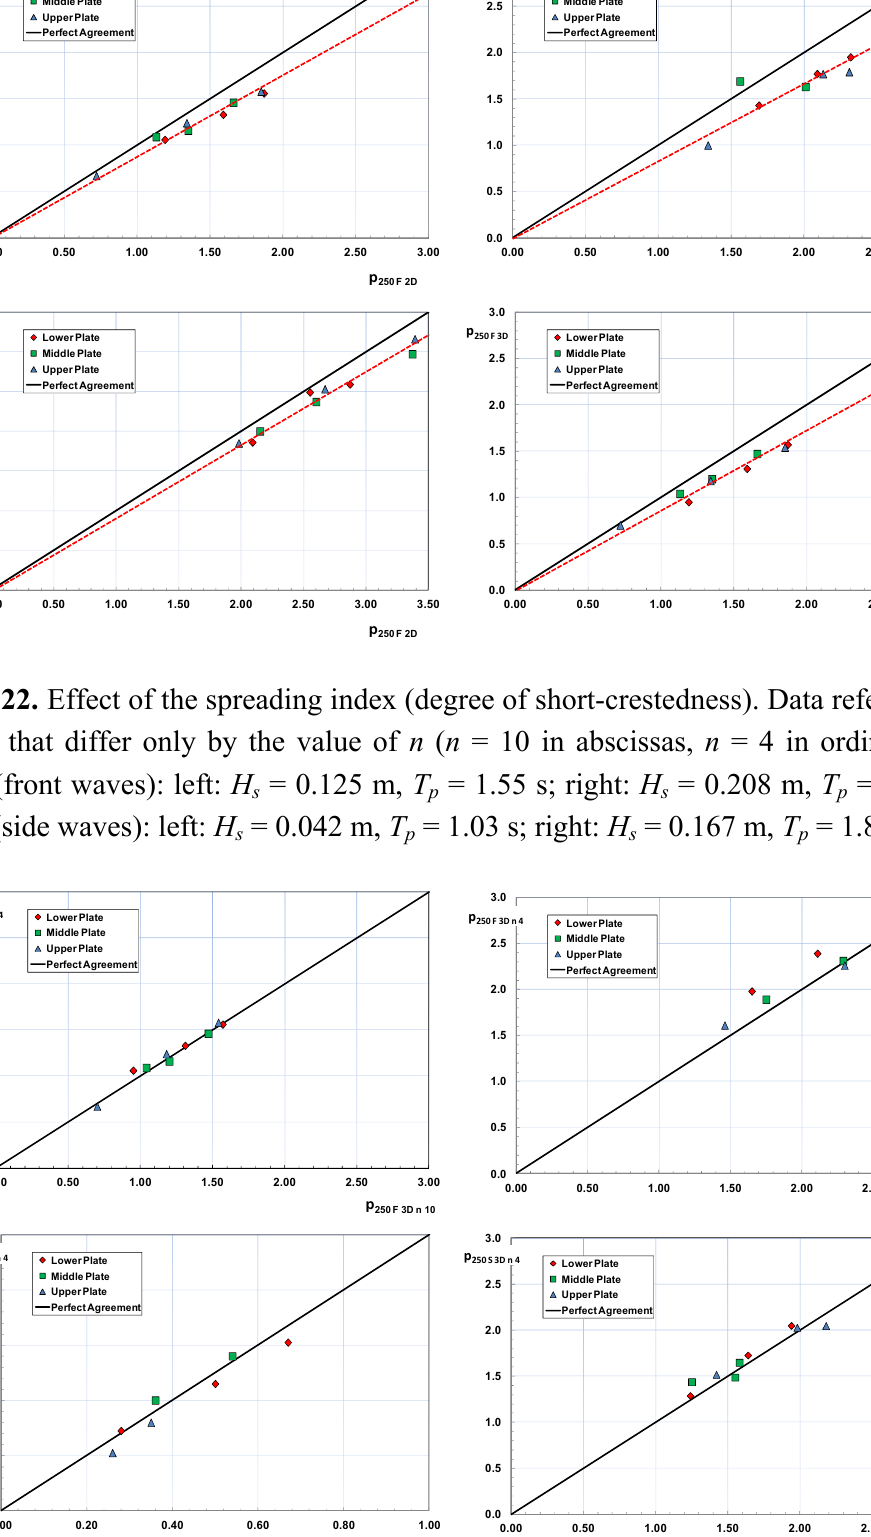
Figure 21. Long crested vs. short crested waves ( n = 4, front waves). Top left: H = 1.55 s. Top right: H T p right: H = 0.125 m, T s